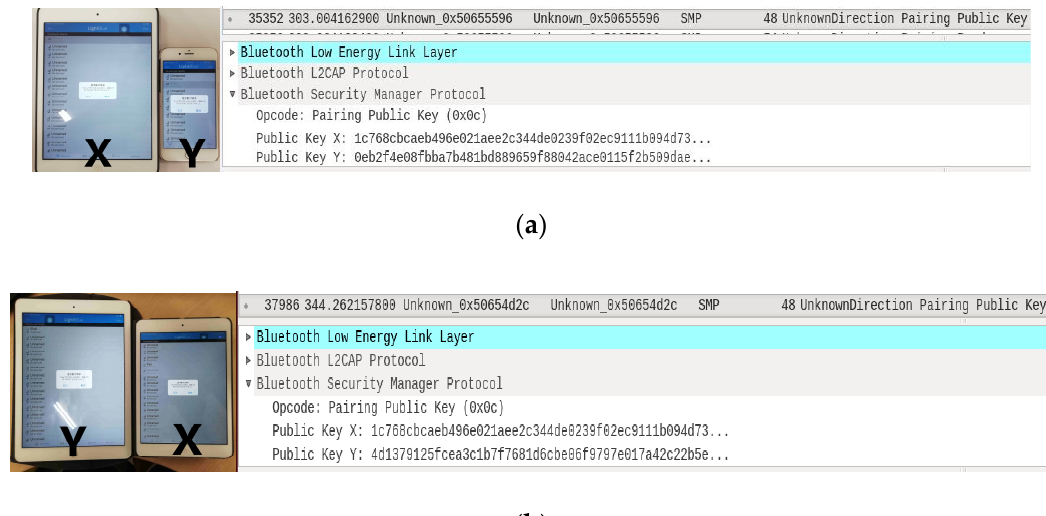
Figure 8. The device X ’s pairing information table. When any two devices X and Y begin to pair, they first search their pairing information tables indexed the device address. If both devices find the other one in their pairing information tables, then they implement an aggressive LESSP protocol Π ’’; else they implement a modified LESSP protocol Π ’, where Π ’ and Π ’’ are respectively proposed in the following two subsections. Figure 9 describes the process flow of ( Π ’, Π ’’). Here, similar to Π *, both Π ’ and Π ’’ should implement the association model to verify the public keys. However, for simplicity, we omit it, because the privacy of the association model is not considered.